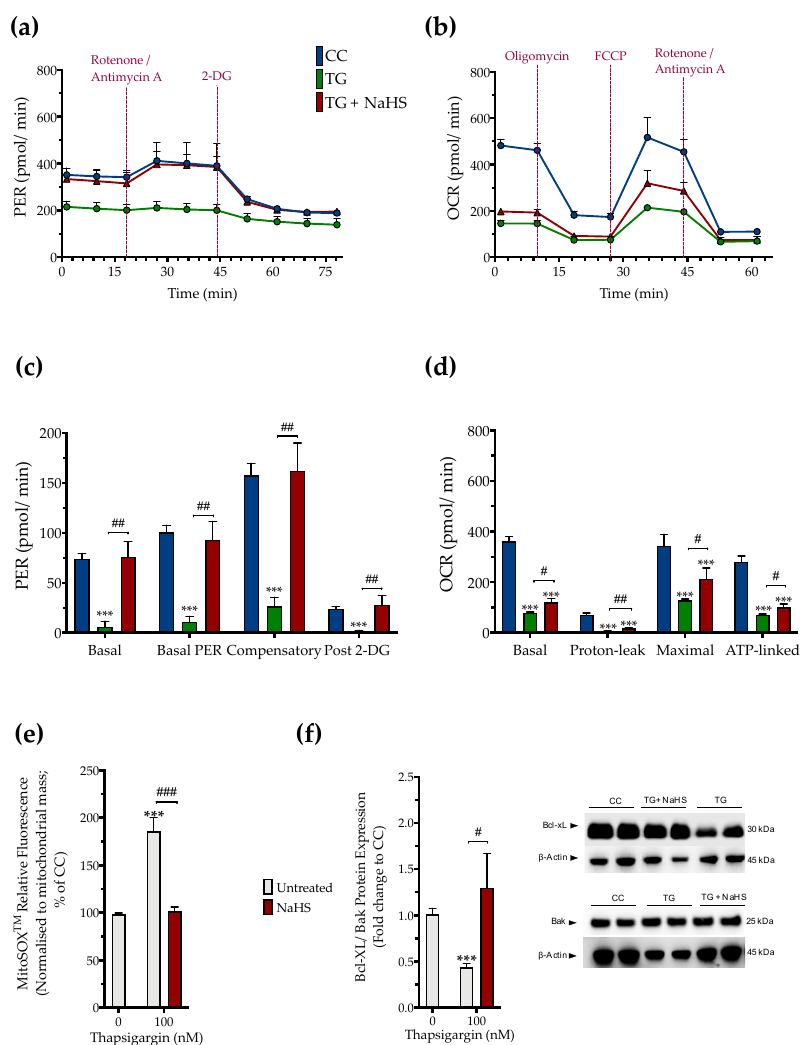
Figure 6. NaHS improves cellular bioenergetics and reduces mitochondrial oxidant production during ER stress. HepG2 cells were serum-starved for 8 h and treated with the vehicle or 100 nM of thapsigargin (TG), in the presence or absence of 100 µ M NaHS for 16 h. We then monitored ( a , c ) the oxygen consumption rate (OCR) over the sequential injection of oligomycin (1 µ M; ATP synthase inhibitor), FCCP (1.5 µ M; mitochondrial uncoupler) and of rotenone + antimycin A (0.5 µ M; Complex I and III inhibitors) and ( b , d ) the proton e ffl ux rate (PER) over the sequential injection of rotenone + antimycin A and 2-deoxy-D-glucose (20 mM) with the Seahorse XFe24 Extracellular Flux Analyzer. We have also quantified ( e ) the relative fluorescence signal of MitoSOX ™ red mitochondrial superoxide indicator and ( f ) the relative expression of Bcl-xL and Bak proteins. Each graph line and bar represent mean ± SEM from four independent experiments. Data are expressed as a fold change of the control (vehicle-treated) conditions (CC). *** p ≤ 0.001 compared to CC; # p ≤ 0.05, ## p ≤ 0.01, ### p ≤ 0.001 compared to the TG-treated